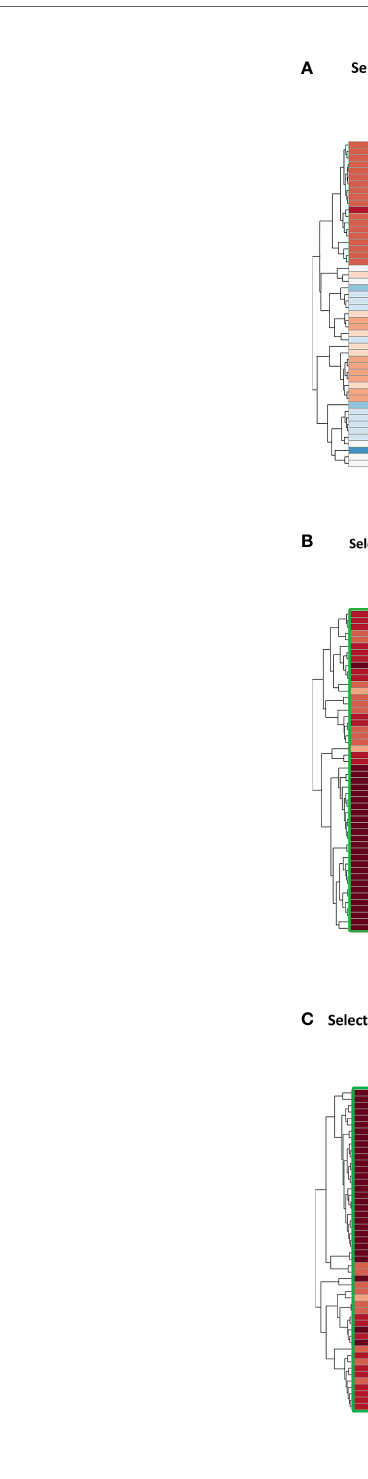
FIGURE 3 | (A) Heatmap of the selected top 50 drug signatures from signature cluster 3 ( Figure S4 ) showing the highest D NES score in the G5 patient group. Signatures of the azathioprin and the ixazomib showed the highest D NES scores in the G5 patient group. MLN2238: Ixazomib. Labeling was carried out based on the following strategy: “ drug name ” _ ” database ” . (B) Heatmap of the selected top 50 drug signatures from signature cluster 1 with the highest D NES score in the G3 patient group. Signatures of SYK kinase inhibitor tamatinib showed the highest D NES scores in the G3 patient group. (C) Heatmap of the selected top 50 drug signatures from signature cluster 4 with the highest D NES score in the G4 patient group. 76% of the top 50 drug signatures for G4 patient group belonged to the proteasome inhibitor bortezomib. 179324-69-7: